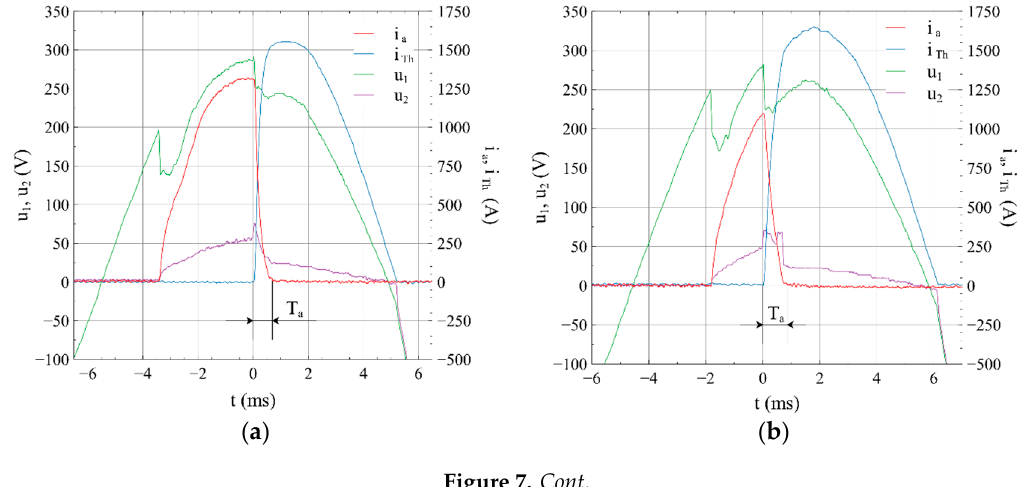
Figure 6. Current waveforms in the load branch ( I a ), current in the thyristor branch ( i Th ), supply voltage ( u 1 ) and voltage measured on the arc source electrodes ( u 2 ) at subsequent arc ignitions ( T a1 = 0.42 ms, T a2 = 0.32